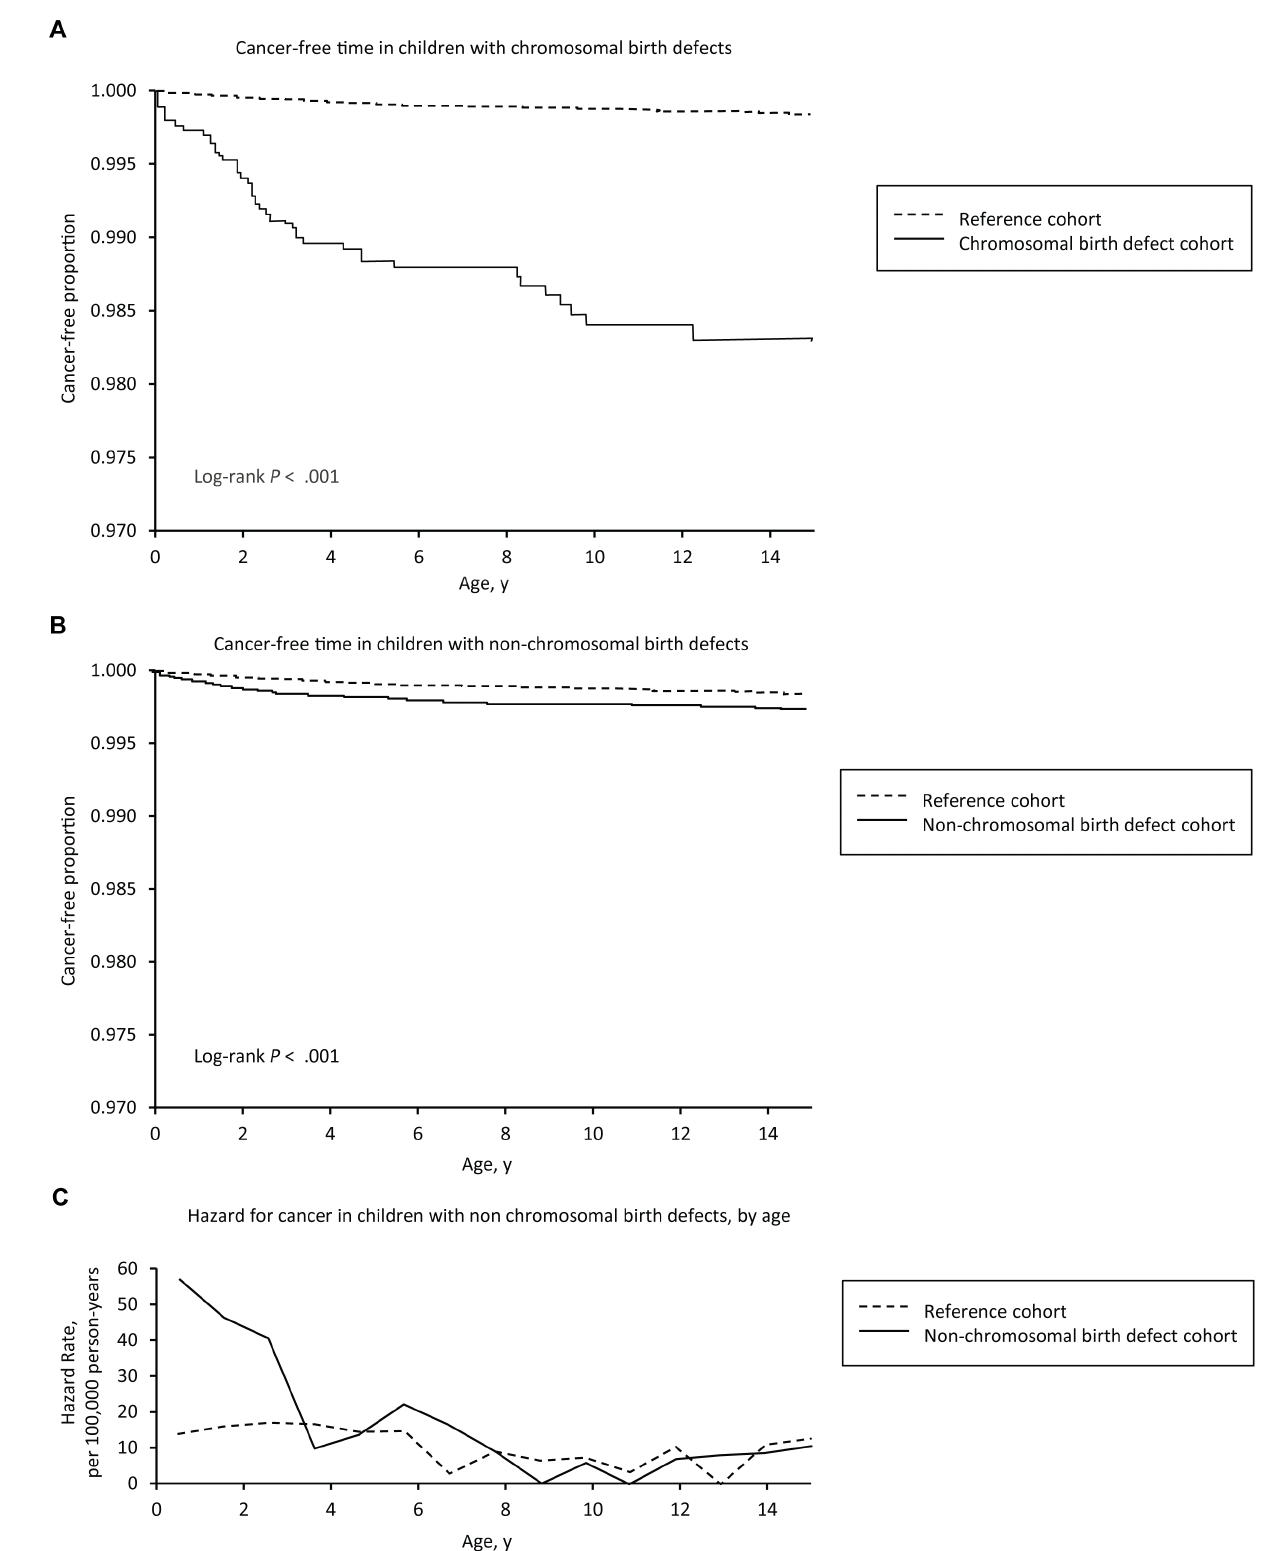
Figure 2. Cancer-free time curves of reference cohort vs. children with chromosomal anomalies (top panel) and children with non- chromosomal birth defects (middle panel), together with hazard rate for cancer by age in reference cohort vs. children with non- chromosomal birth defects (lower panel).